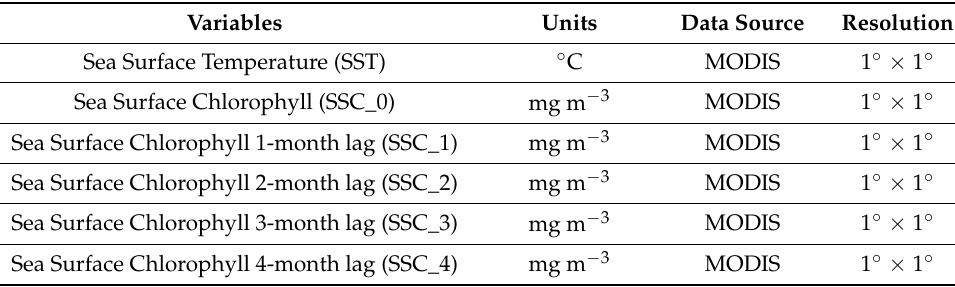
Table 1. Remotely sensed variables applied in the model and their data sources.